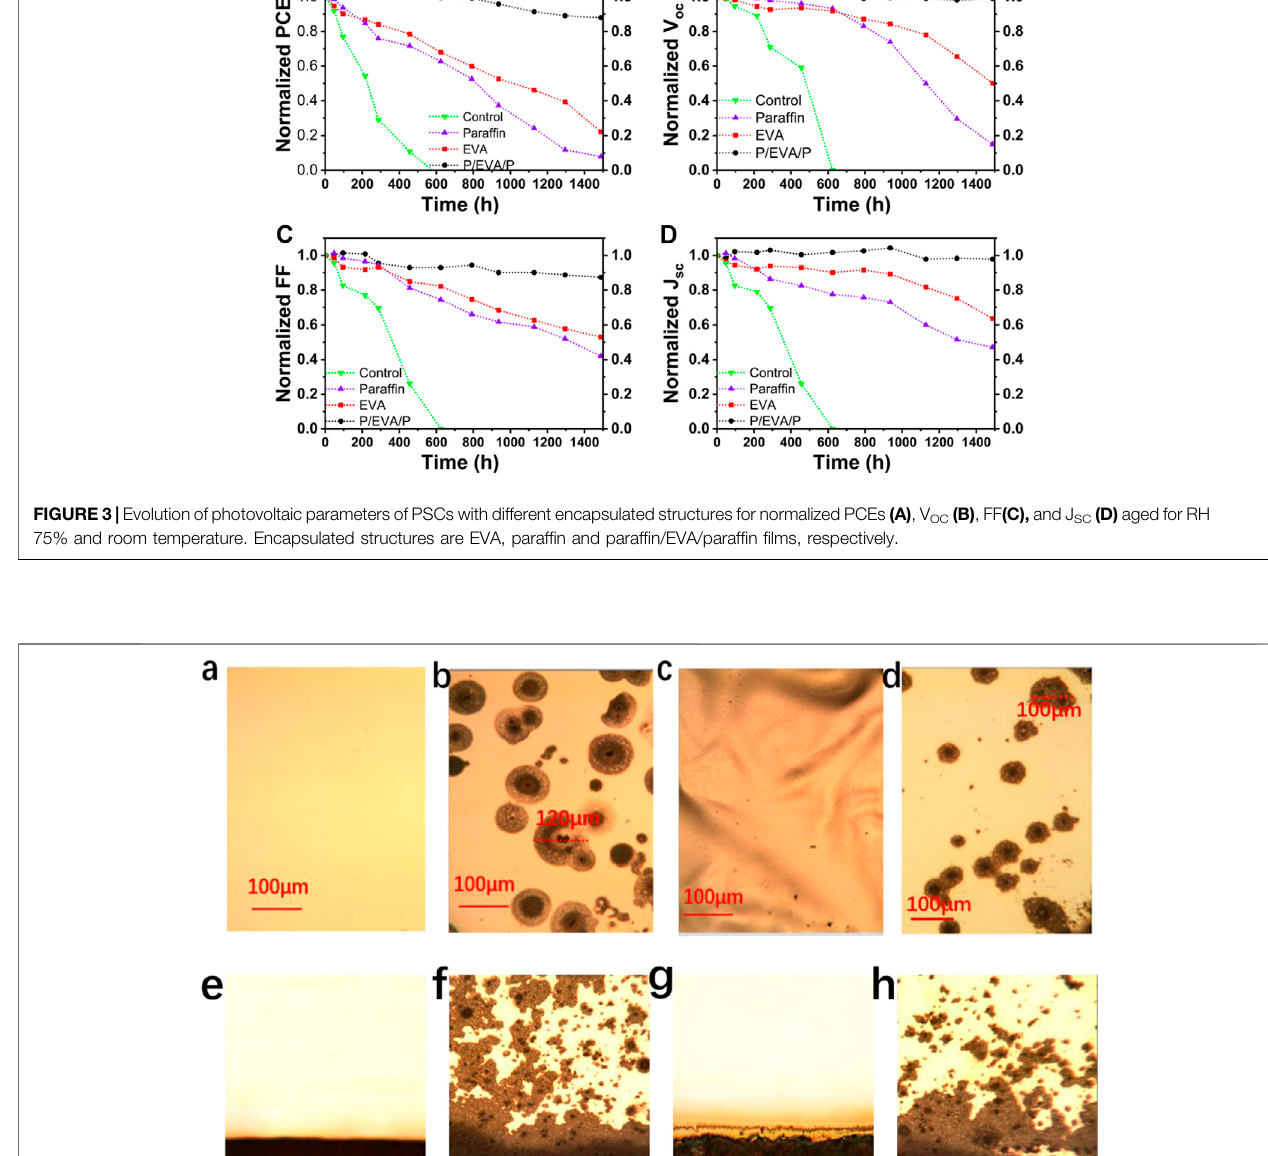
FIGURE 4 | Metallurgical microscope images of middle (A) and edge (E) of pristine AgAl electrodes, middle (B) and edge (F) of AgAl electrodes without encapsulation, middle (C) and edge (G) of AgAl electrodes with paraf fi n/EVA/paraf fi n encapsulation, middle (D) and edge (H) of AgAl electrodes with pure EVA encapsulation aged for RH 75% and room